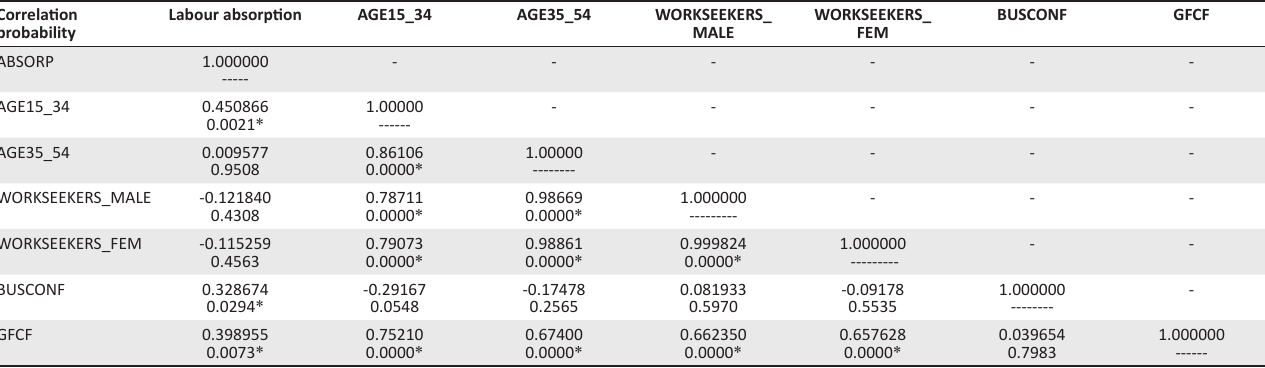
TABLE 2: Estimated correlation matrix results. Correlation probability